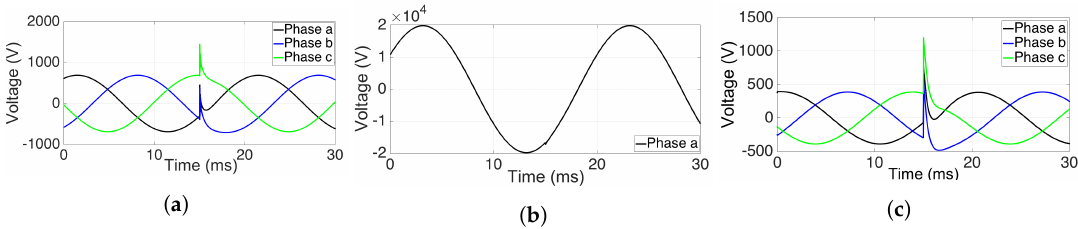
Figure 9. Impact of increased horizontal conductor on transient overvoltages. ( a ) LV side of the main transformer; ( b ) HV side of the main transformer from node to ground; ( c ) control circuits.